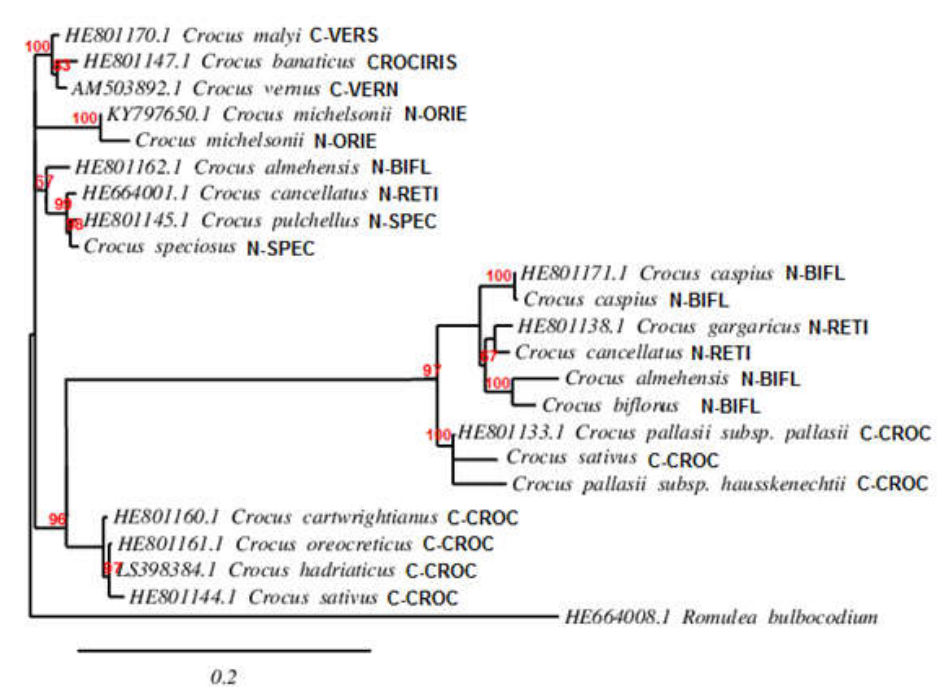
Fig. 7. The phylogenic tree derived from the analysis of ITS+ mat K+ rbc L+ trn L region data by the Bayesian method, the number above each branch shows the bootstrap